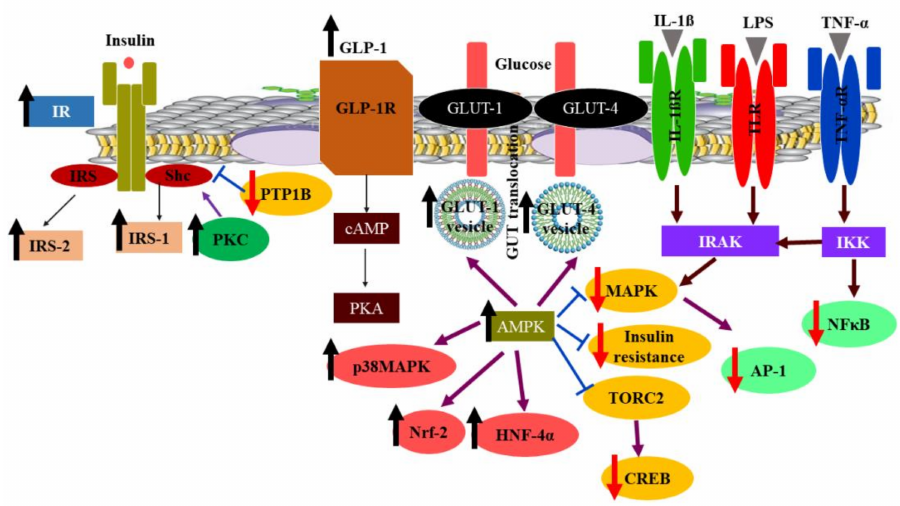
Figure 6. Molecular pathways of BER in ameliorating NIDDM. InsR: insulin receptor, IRS: insulin receptor substrate, IRS-1: insulin receptor substrate-1, IRS-2: insulin receptor substrate-2, Shc: mammalian Shc locus encoding three protein variants with molecular mass of 46, 52, and 66 kDa and identical modular structure, PKC: protein kinase C, PTP1B: protein tyrosine phosphatase 1B, GLP-1: glucagon-like peptide-1, GLP-IR: